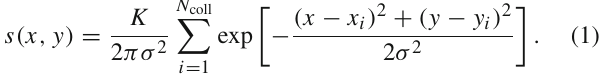
Fig. 1 The elliptic (left panel) and triangular (right panel) eccentricity distribution of Pb–Pb collisions at centrality